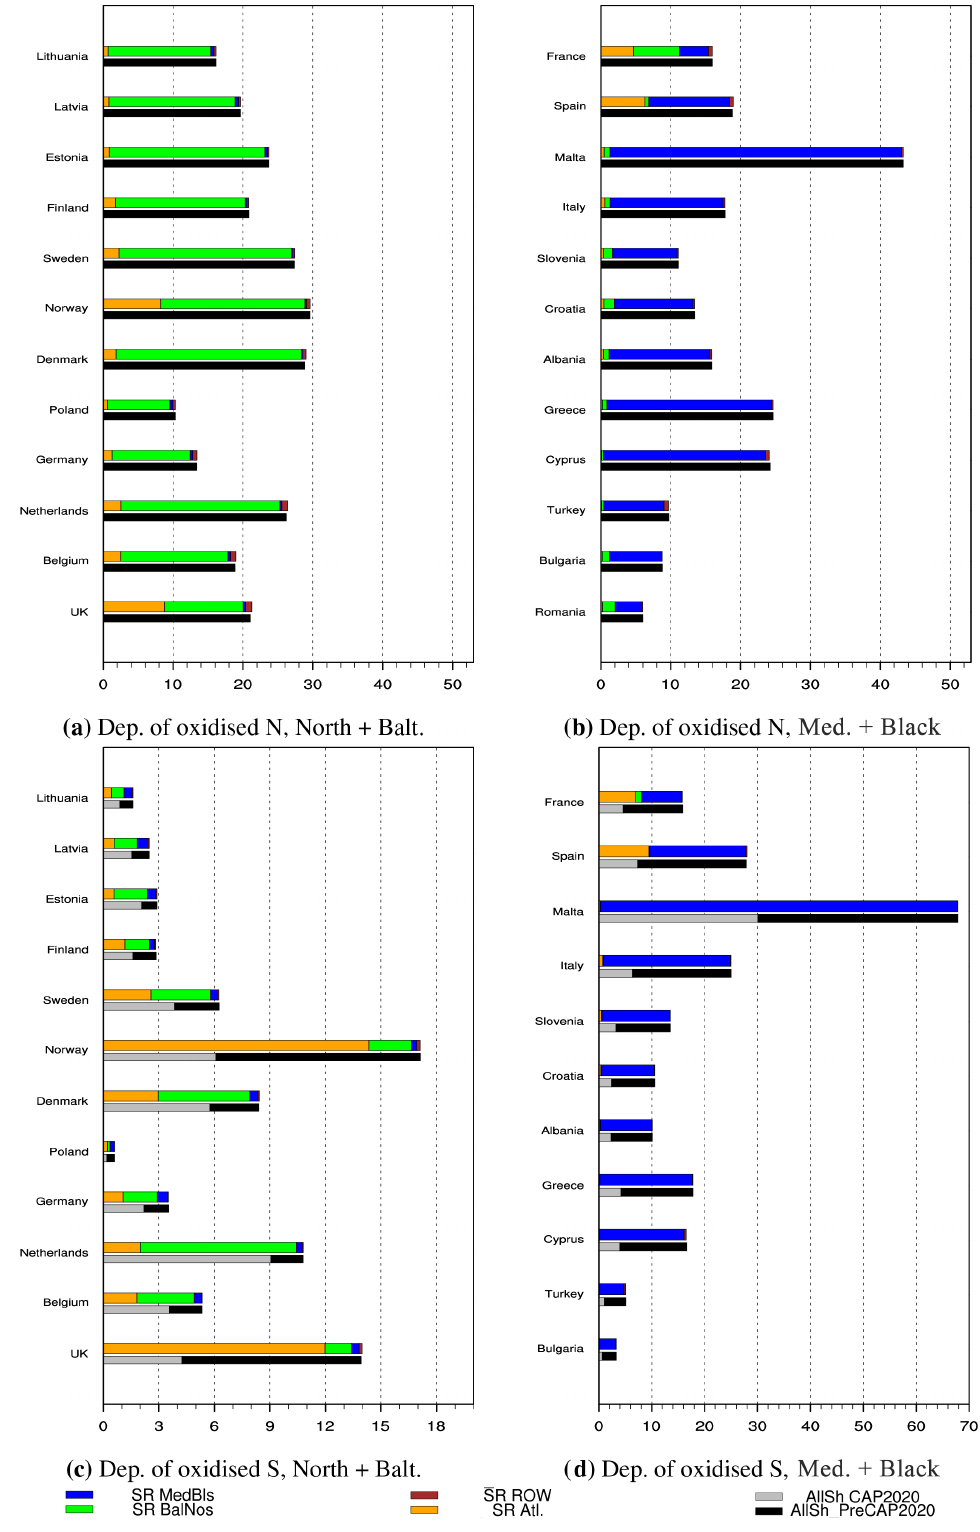
Figure 7. Percentage contributions from shipping to annually averaged depositions of oxidised nitrogen (a, b) and sulfur (c, d) relative to contributions from all global anthropogenic emissions. Contributions are shown for all ships and separated by sea area. See also caption in Fig.